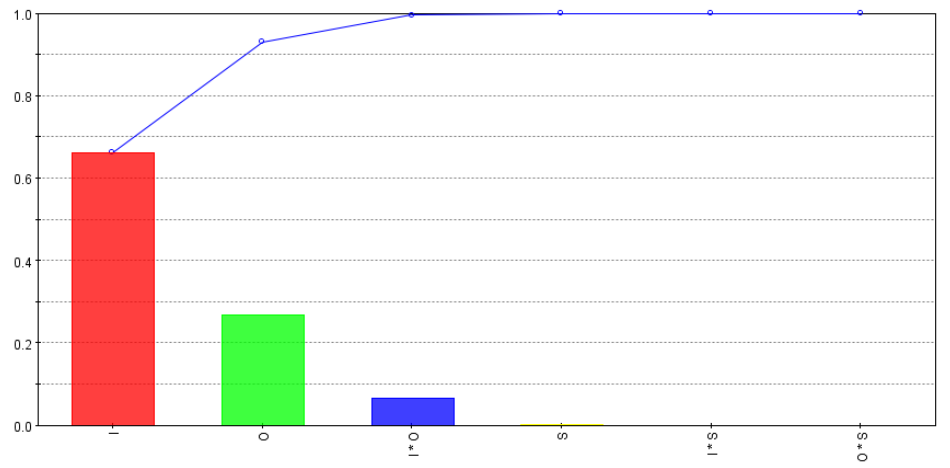
Figure 5. Relative strength of input variables and their interactions for depth per scan ( d s ).